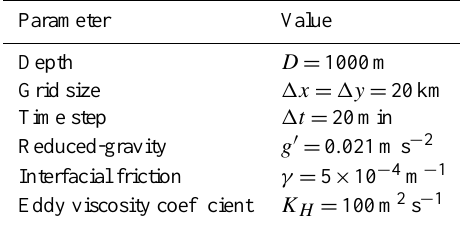
Table 1. Parameter values used in the